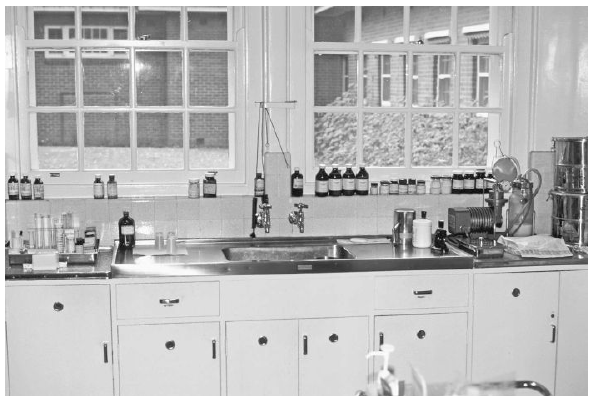
Figure 10. The kitchen at Bundoora Repatriation Mental Hospital where John Cade conducted some of his lithium experiments.